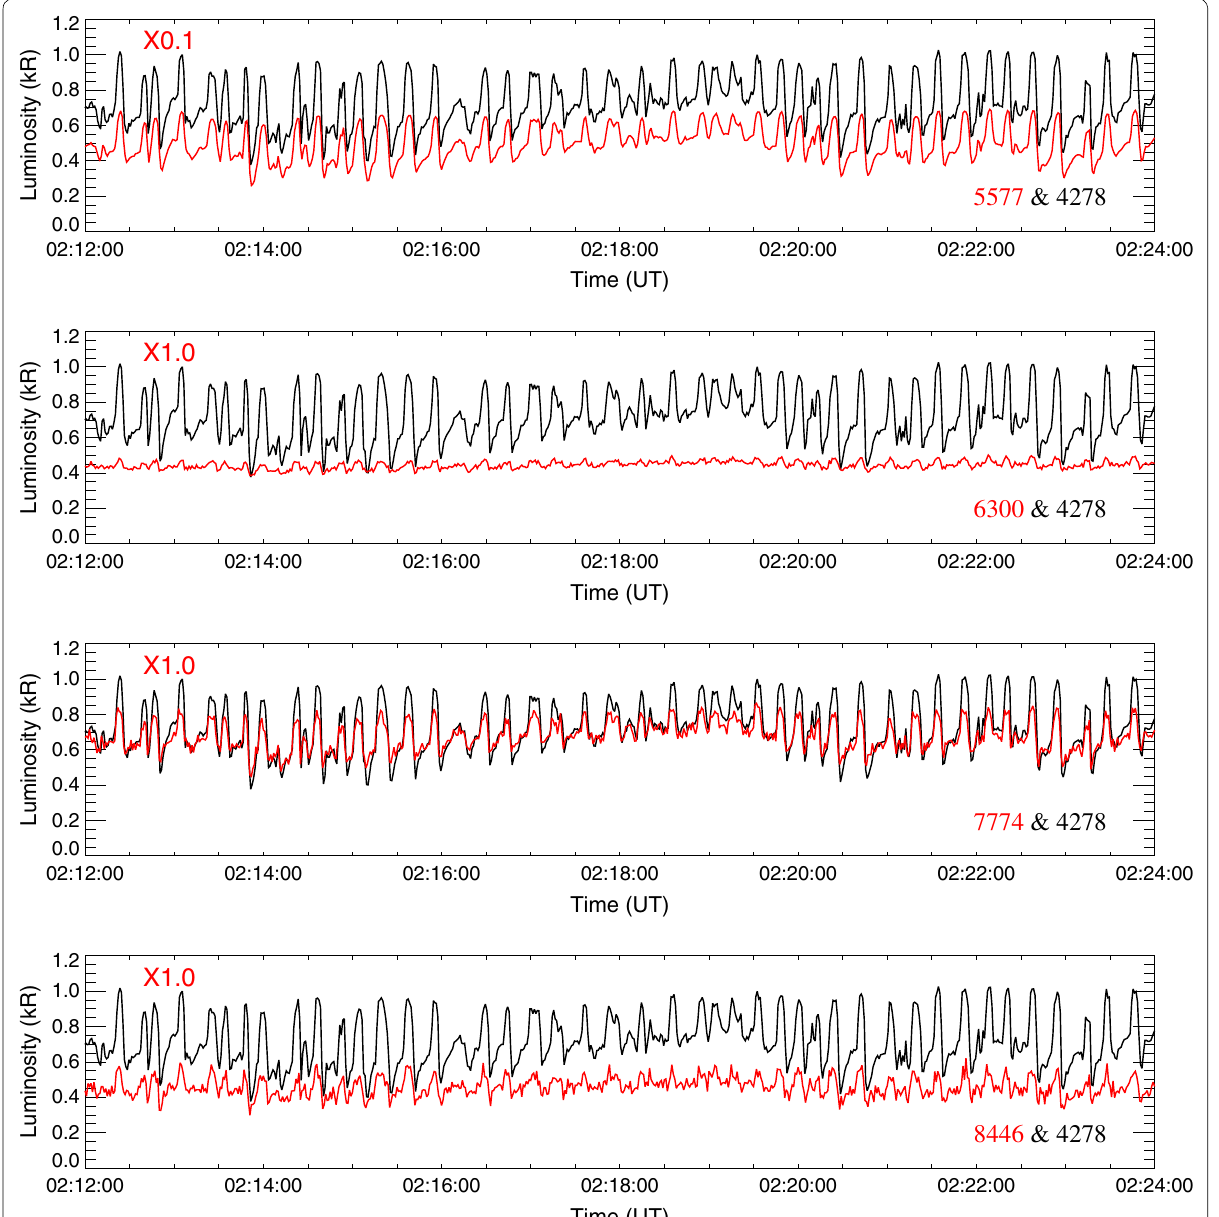
Fig. 19 Comparisons of temporal variations of auroral emissions (1 s data used) between 427.8 nm (black line) and 557.7 nm, 630 nm, 777.4 nm, 844.6 nm from top to bottom are presented for 12 min between 02:12:00 and 02:24:00 UT on January 23, 2018. The emission intensity values of 557. 7 nm, 630 nm, 777.4 nm, and 844.6 nm are multiplied by 0.1, 1, 1, and 1, respectively, and shown in red solid